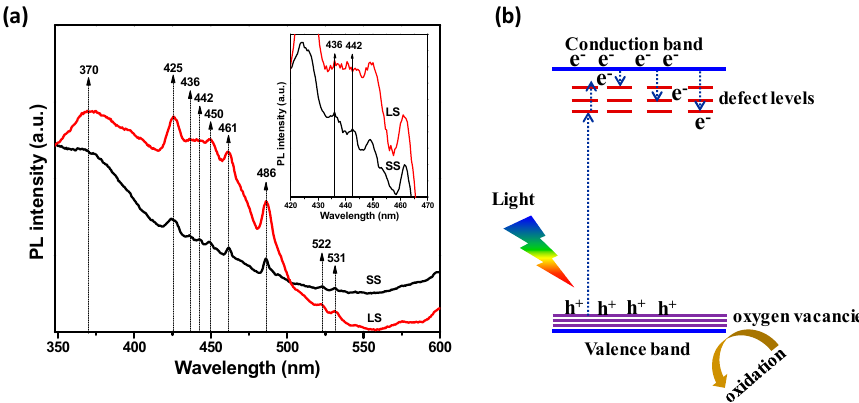
Figure 8. ( a ) Photoluminescence (PL) emission spectra of the SS and LS samples; inset shows the magnified part of the spectra; ( b ) schematic representation of the photochemical process of surface defective SnO 2 .